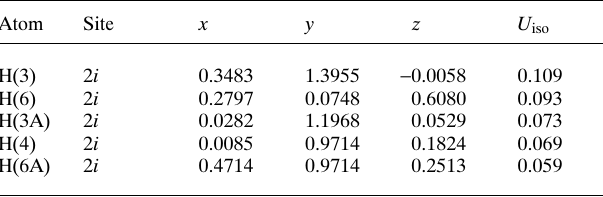
Table 2. Atomic coordinates and displacement parameters (in Å 2 )